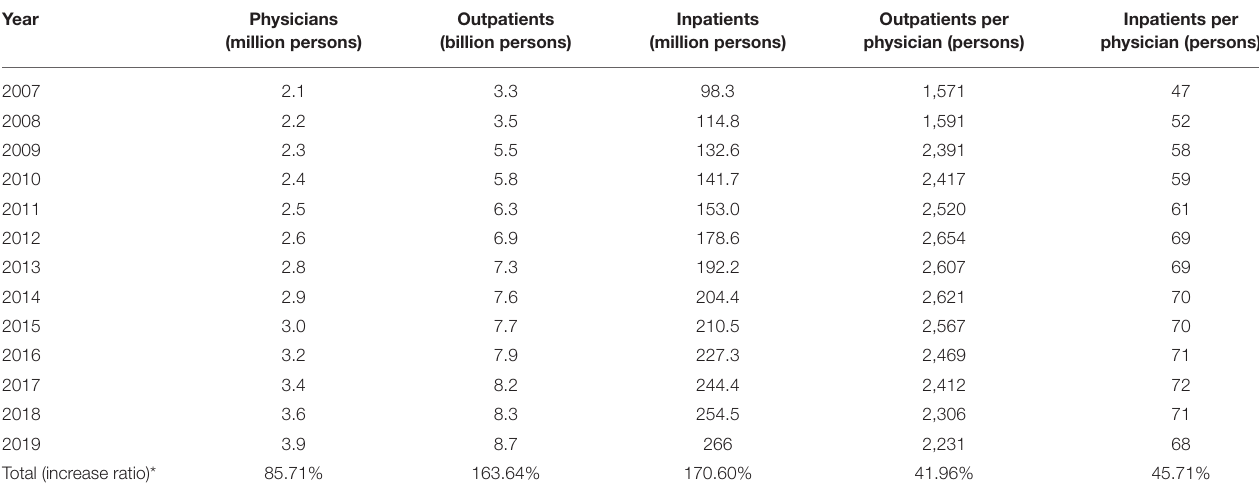
TABLE 4 | Number of professionally active physicians, outpatients, and inpatients in China from 2007 to